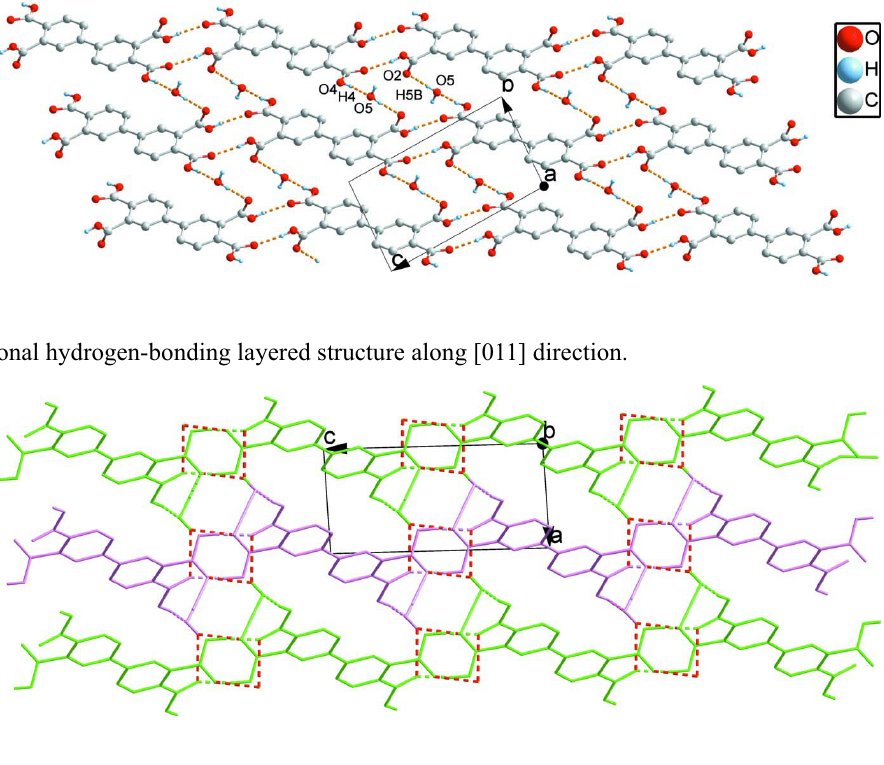
Figure 4 The three dimensional hydrogen-bonded supramolecular network. The adjacent layers are shown in green and rose colors, and interlayer hydrogen bonds are shown as red dashed